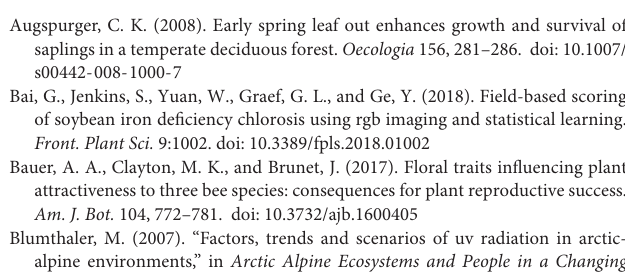
Supplementary Figure 1 | Specific leaf area had a significant correlation with the hue–saturation–lightness color space (petal L and petal S) of Lonicera nervosa . Supplementary Figure 2 | The visitation of a bumblebee to the flowers of Lonicera nervosa . Supplementary Figure 3 | Piecewise regression of the traits at different